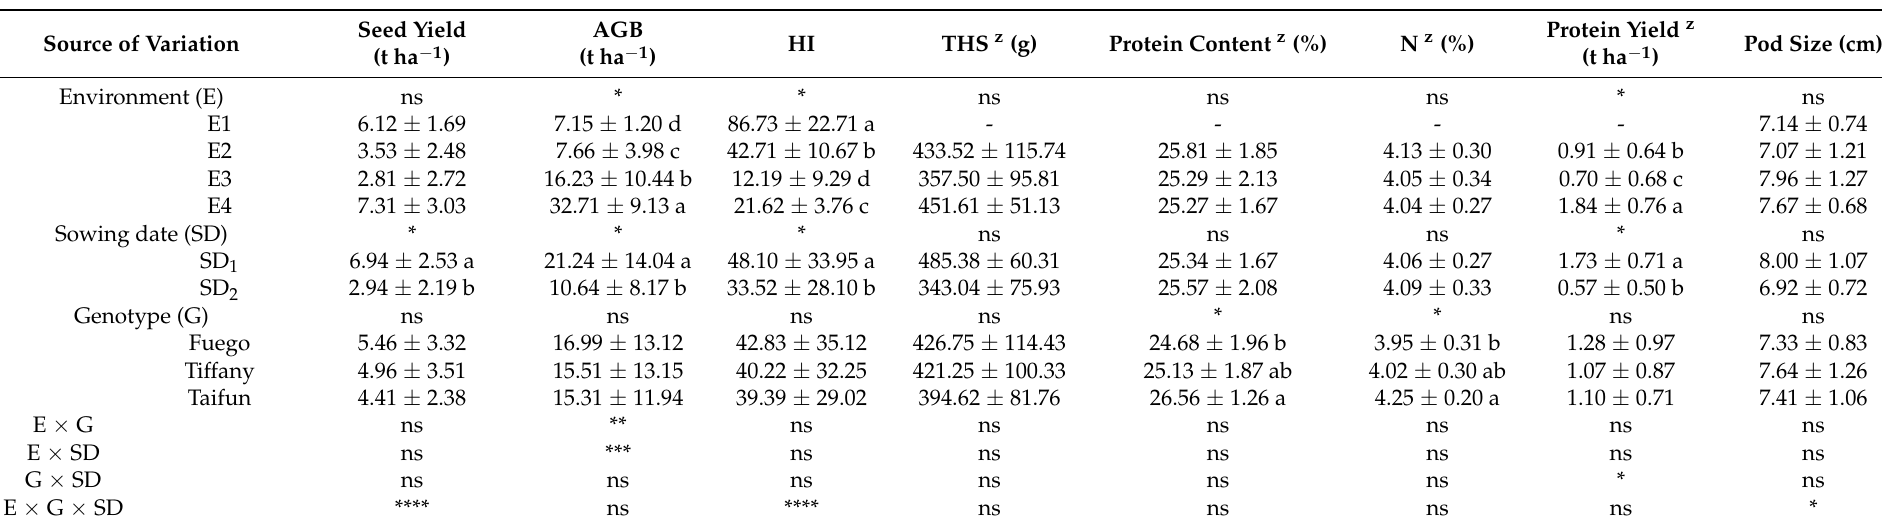
Table 5. Faba bean seed yield, above-ground biomass, HI, weight of 1000 seeds (THS), protein content, azote, and protein yield as affected by environment, sowing date, and genotype. Source of